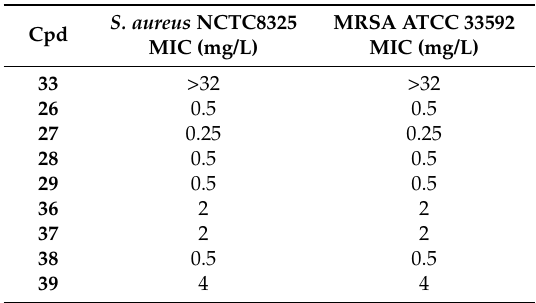
Table 5. Antibacterial activity of 26 , oxacillin and vancomycin against S. aureus , MRSA, VISA